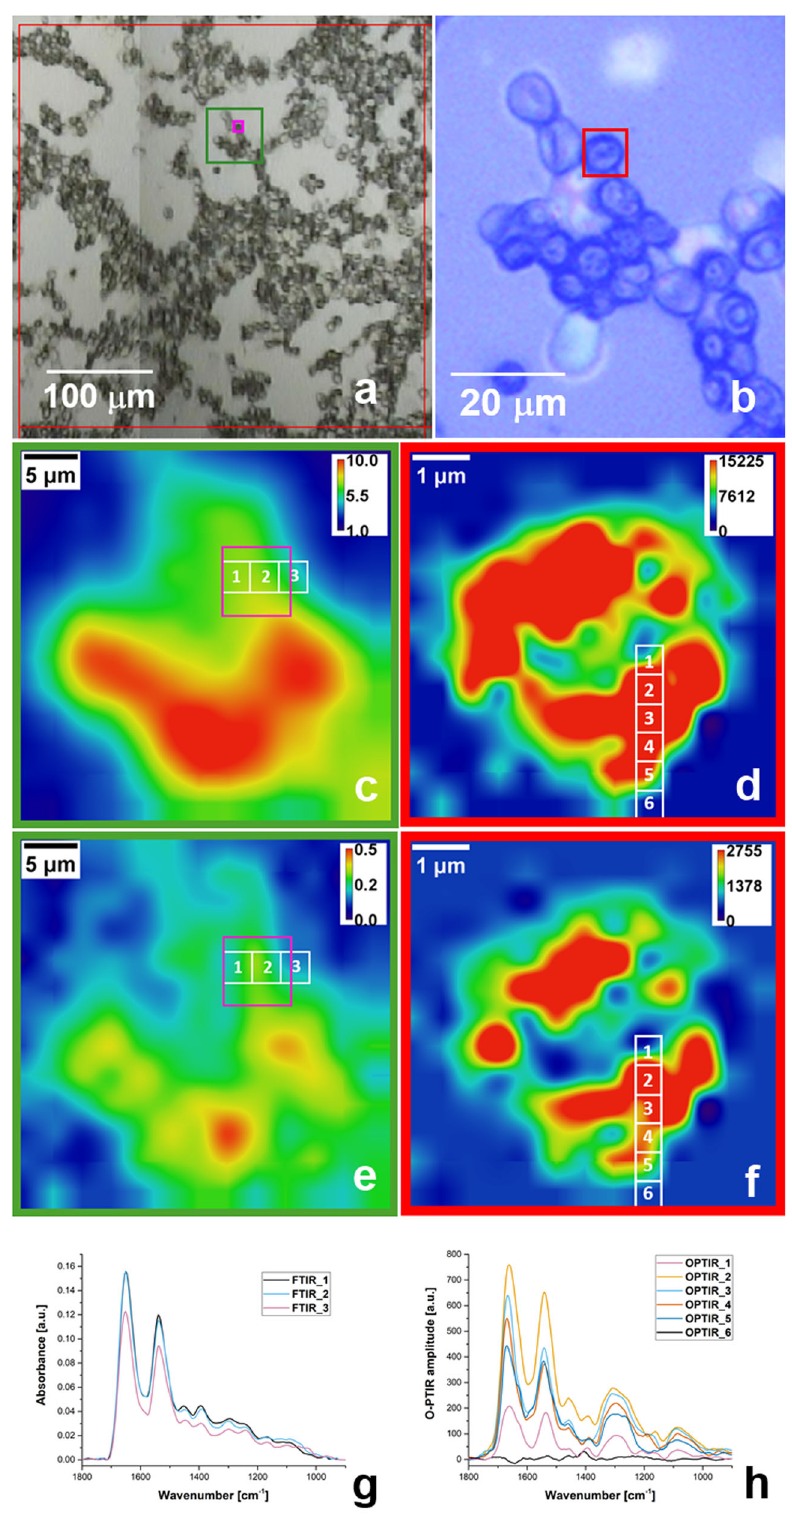
Fig. 2 Comparison of results for single RBC (control) by FTIR microspectroscopy and O-PTIR spectroscopy. Screenshots showing the area selected for FTIR microspectroscopy experiment ( a ), red square denotes the area being analyzed during one single FPA measurement (128 pixel × 128 pixel), small pink square marks the position of a selected RBC; and O-PTIR ( b ), red square contains the area chosen for hyperspectral experiment (one single cell). Chemical map reconstructed for amide I and proteins/lipids distributions by means of FTIR microspectroscopy ( c , e ), and O-PTIR spectroscopy ( d , f ). In Fig. 2c and e only zoomed region displaying 13 × 13 of 128 × 128 single elements of FPA including cell of interest is presented (marked by pink square). Comparison of spectra collected by means of FTIR microspectroscopy ( g ) and O-PTIR spectroscopy ( h ). Spectra were recorded from the points marked in c , e and d , f , respectively. Distance between spectra is equal 2.7 μ m for FTIR microspectroscopy and 0.5 μ m for O-PTIR.